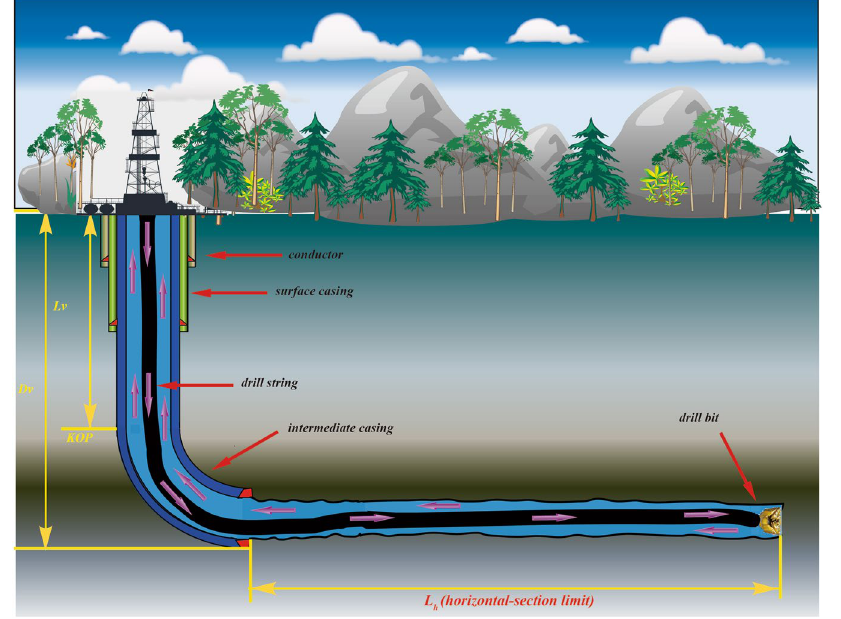
Figure 1. Schematic overview of the horizontal extended-reach